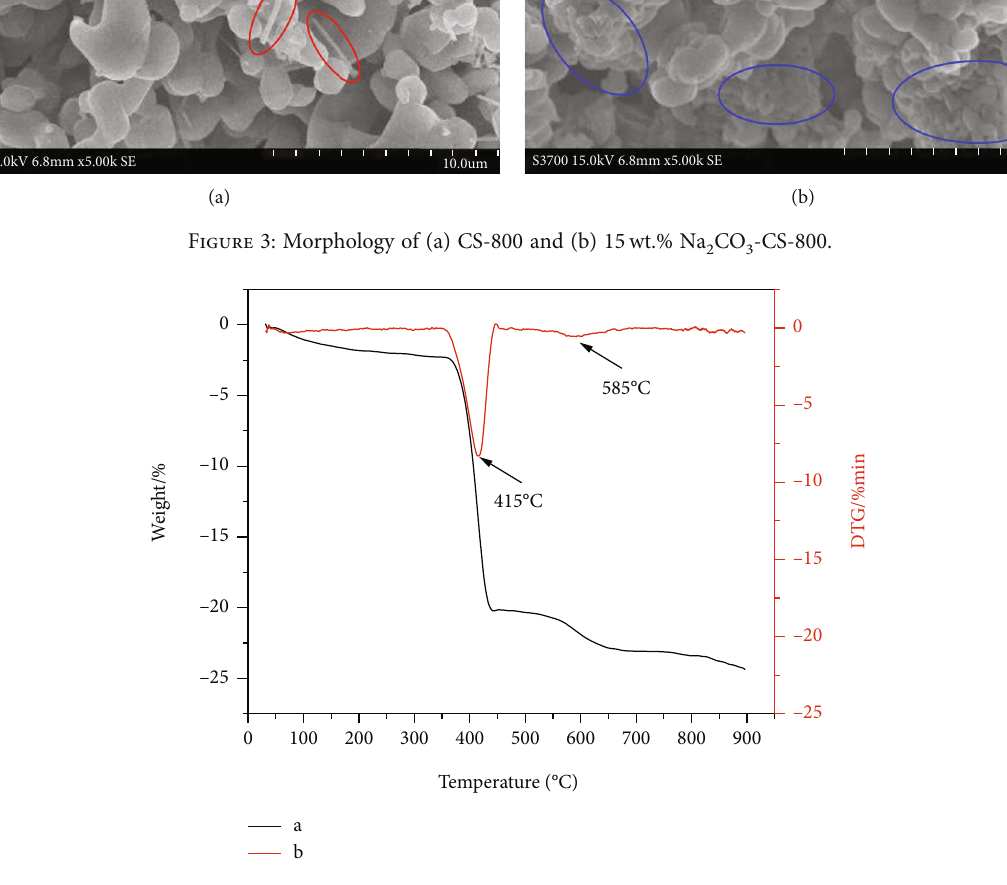
Figure 4: TGA and DTG curves of 15wt.% Na